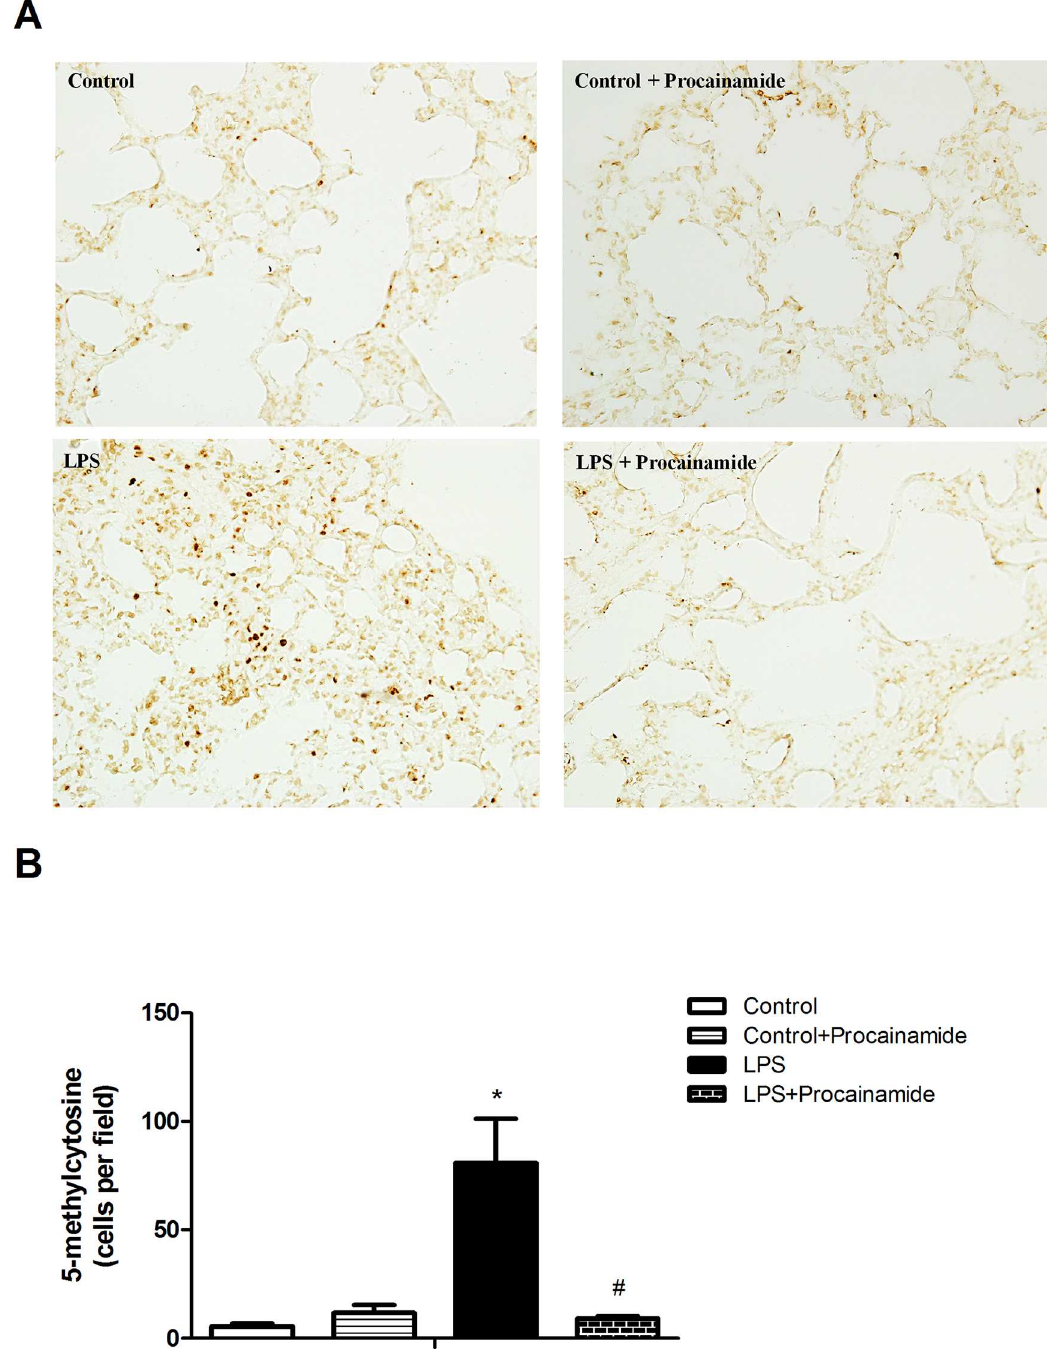
Fig 7. (A) Detection of 5-methylcytosine by immunohistochemistry and (B) the numbers of 5-methylcytosine positive cells in the lungs obtained from different groups of animals. Depicted are changes in the numbers of lung 5-methylcytosine positive cells at the end of experiment (at 6 h) in different groups of rats that received saline at time 0 (Control, n = 3), received saline as in Control group and then received procainamide at 1 h (Control + Procainamide, n = 3), received LPS at time 0 (LPS, n = 3), and received LPS at time 0 and then received procainamide at 1 h (LPS + Procainamide, n = 3). Data are expressed as mean ± SEM. * P < 0.05, all versus Control rats; # P < 0.05, with versus without procainamide in LPS rats. Original magnification x